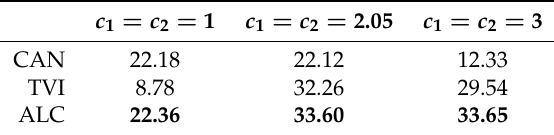
Table 2. Mahalanobis distance achieved with Canonical PSO (CAN), time-varying inertia PSO (TVI) and ageing leader and challengers PSO (ALC) for the experiment with partial discharges and FM radio disturbances.